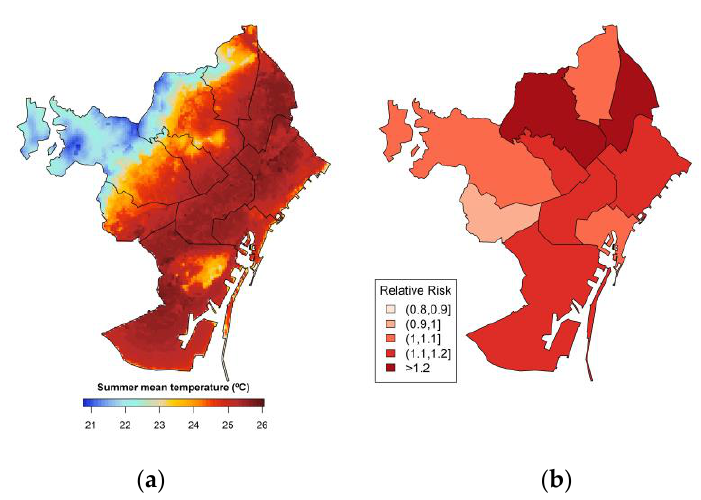
Figure 1. ( a ) Map of summer mean (1 June–30 September) temperature in (˚C) and ( b ) relative risk map of all-cause mortality related to summer extreme temperatures by district during the study period 1992–2015 in Barcelona.